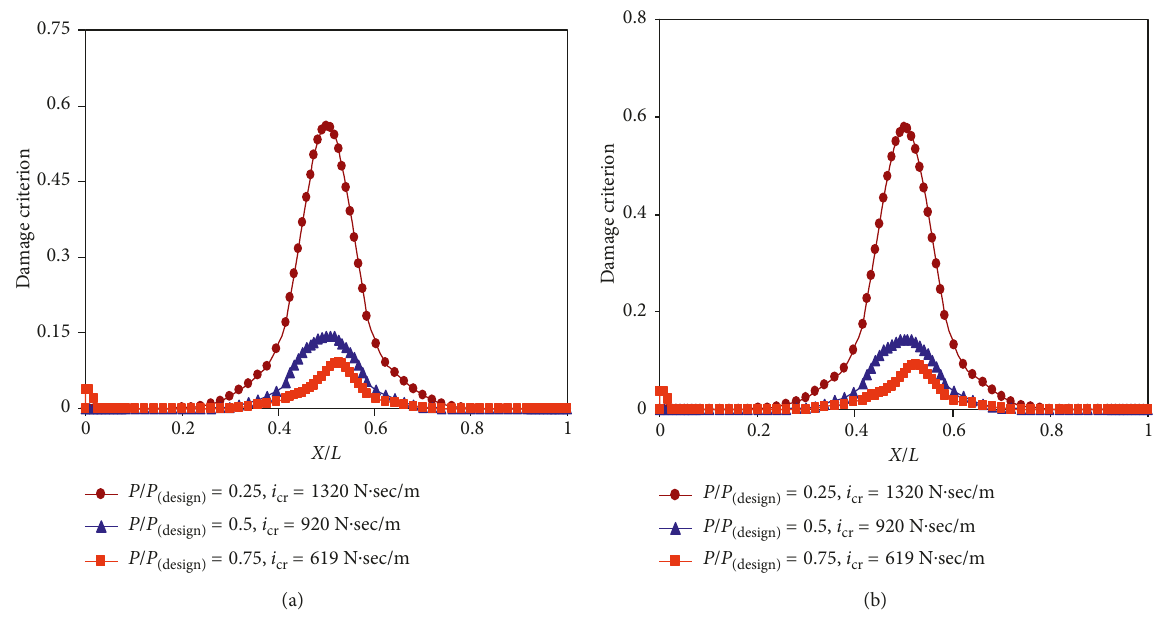
Figure 17: Damage initiation criterion profile of simply supported column W200 of the tension flange; (b) at the middle of the